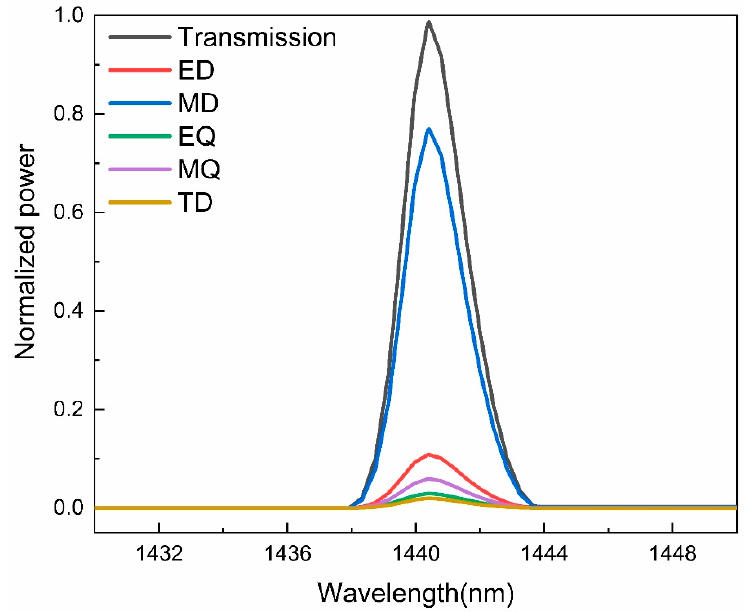
Figure 5. Normalized scattered power of multipoles of the proposed metamaterial, including elec- tric dipole (ED), magnetic dipole (MD), electric quadrupole (EQ), magnetic quadrupole (MQ), and toroidal dipole (TD).